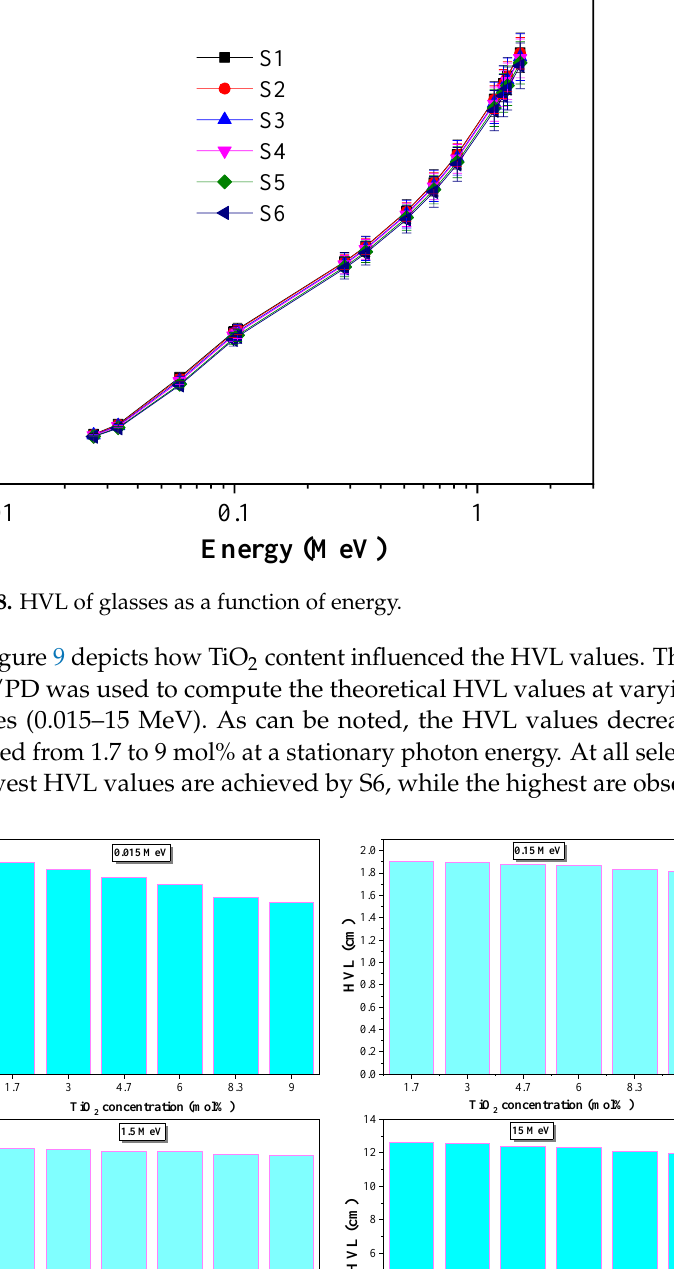
Figure 9. Changes in HVL in the glasses at stationary gamma photon energy (0.015, 0.15, 1.5, and 15 MeV).